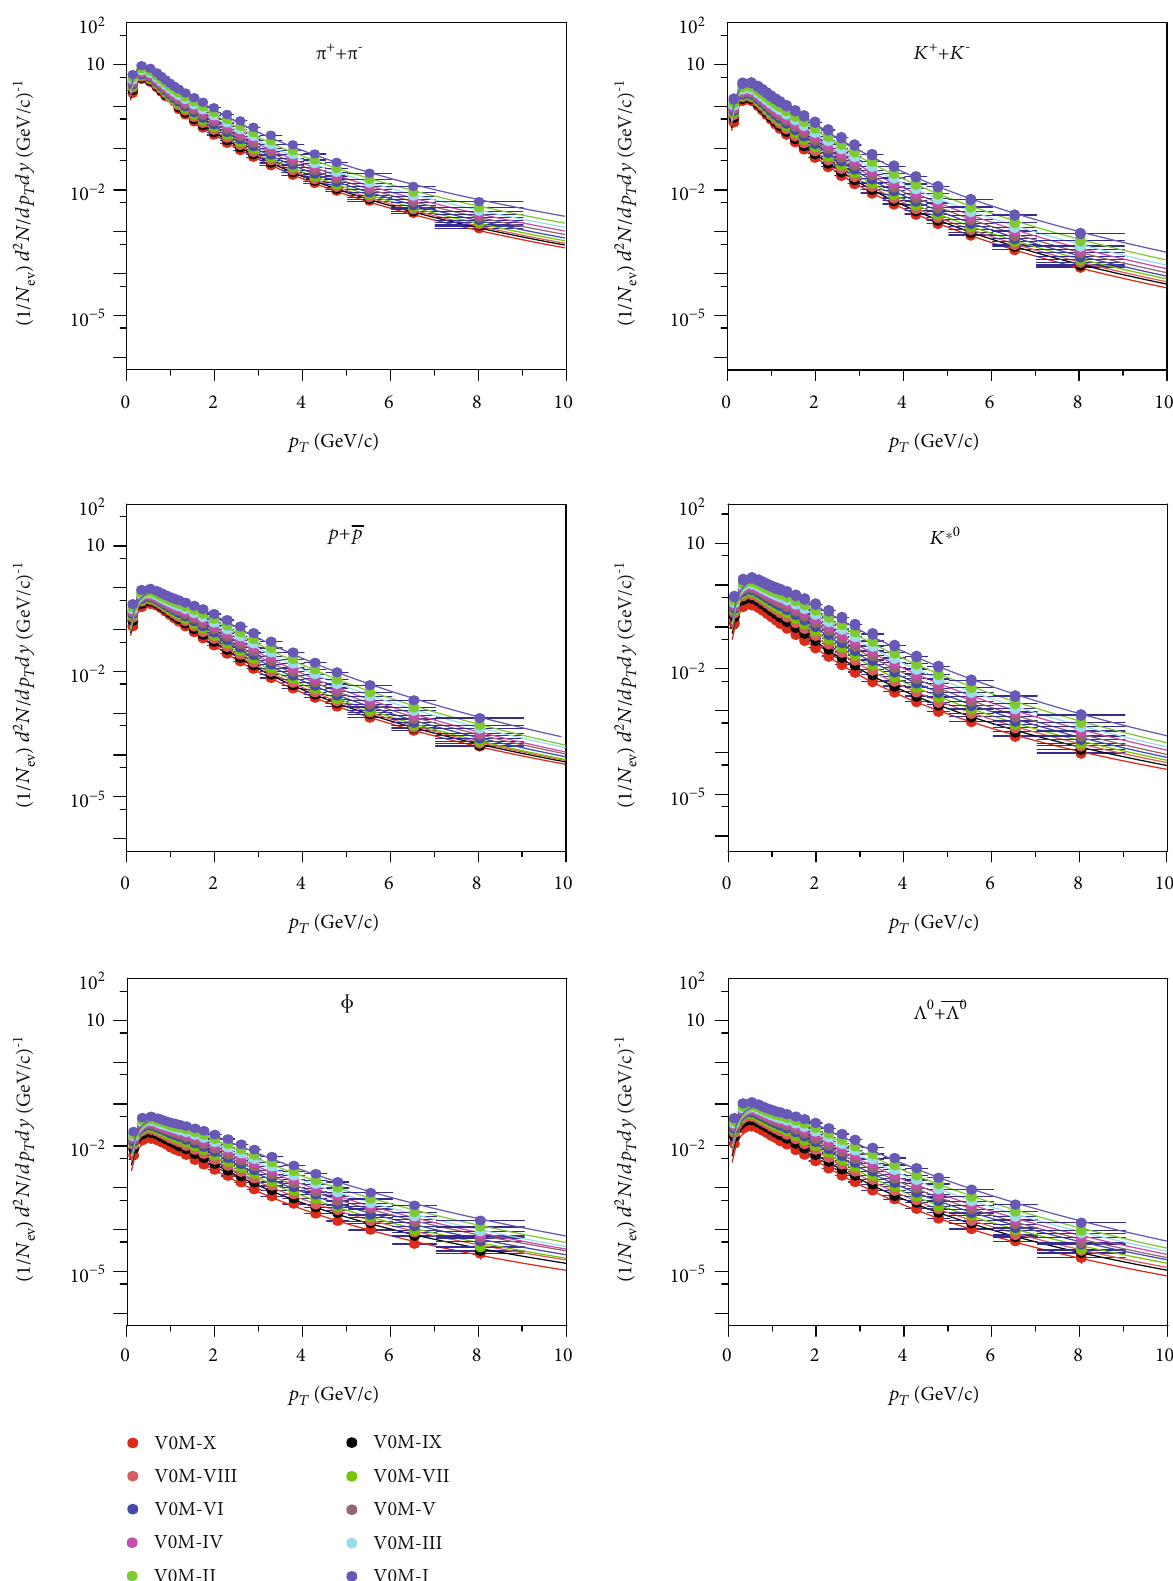
Figure 6: (Color online) Fitting of generated p various multiplicity classes as shown in Table